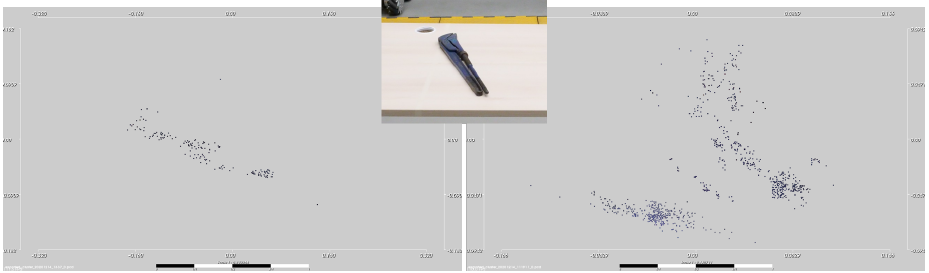
Figure 9. Two data samples in the training set “tongs” taken from different poses in the